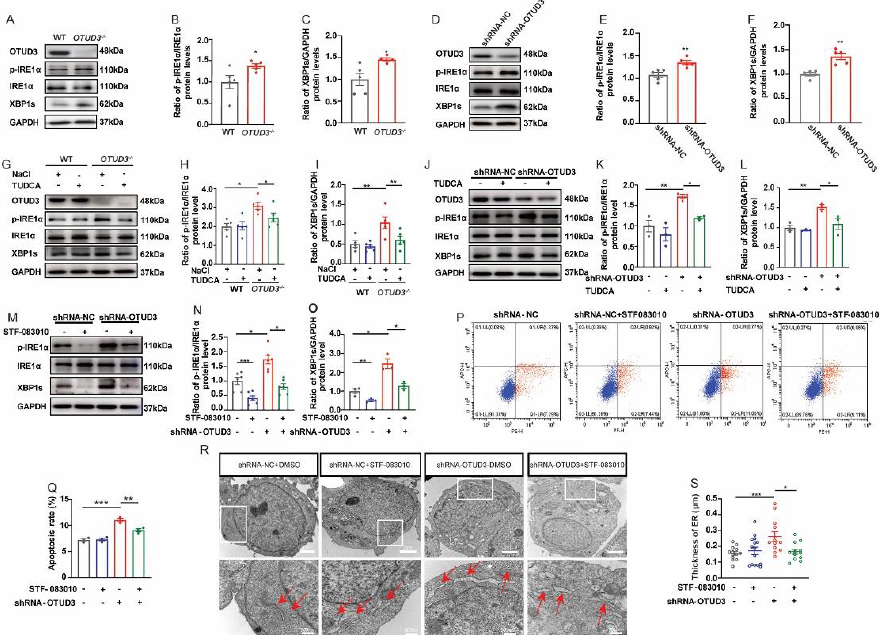
Figure 4. OTUD3 knockdown- induced ER stress by actives IRE1α pathway . ( A − C ) Western blotting